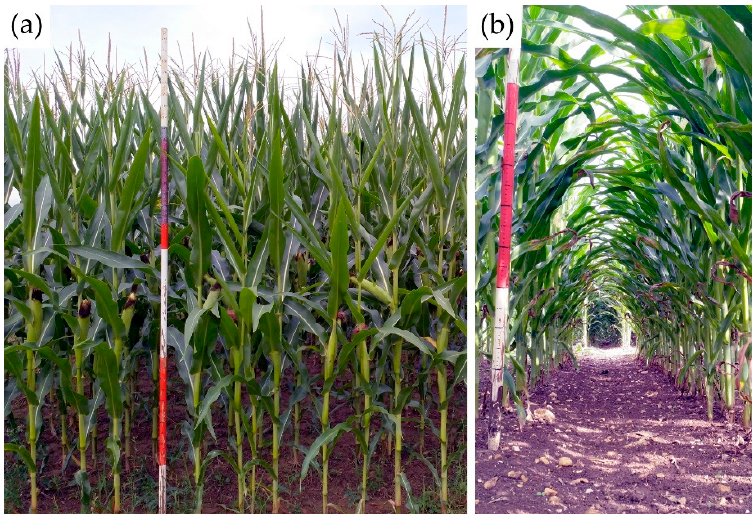
Figure 3 Figure 2. Mono-cropped maize ( Zea mays L.) in Hohenheim ( a ) and Sankt Johann ( b ), Southwest Germany, August